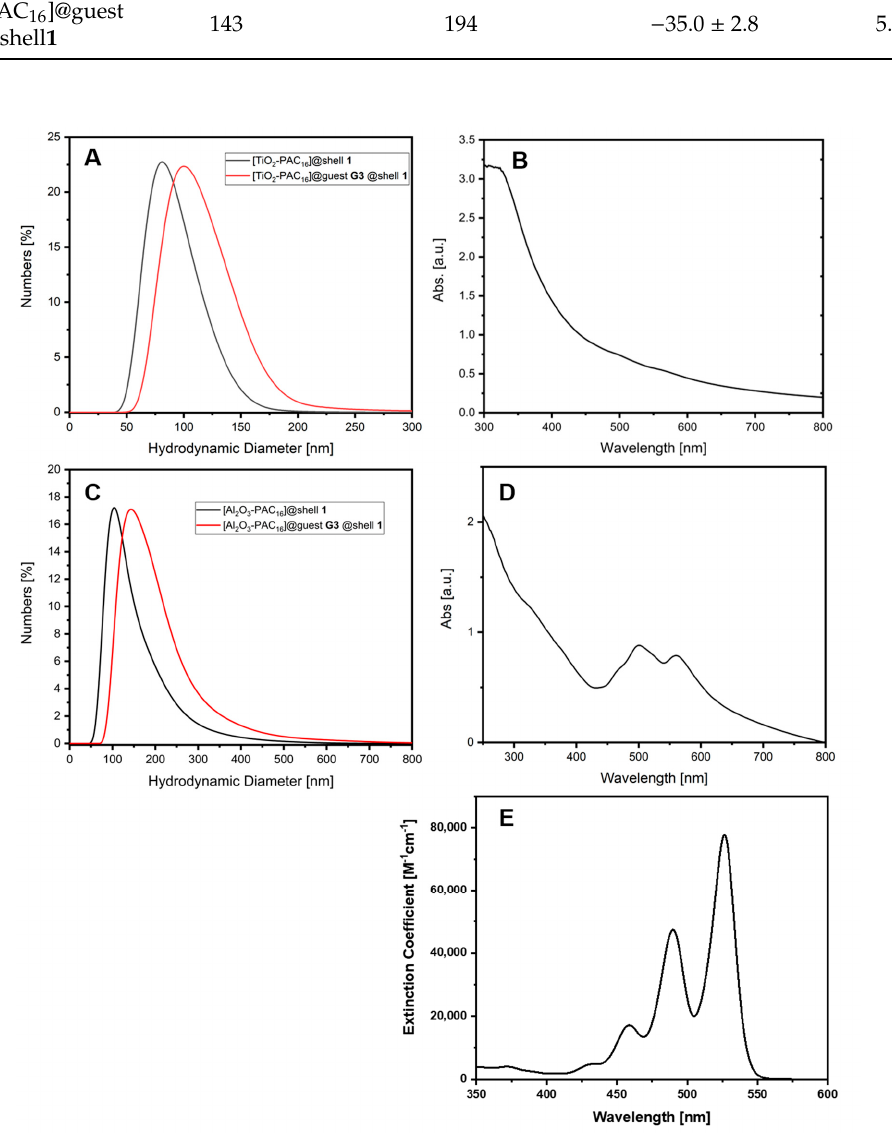
Figure 3. Comparison of the hydrodynamic diameters of the unloaded nanocarriers with that of the nanocarriers loaded with G3 (perylendiimide): ( A ) TiO 2 nanocarriers, ( C ) Al 2 O 3 nanocarriers; UV/Vis spectrum of the loaded nanocarriers [TiO 2 -PAC 16 ]@guest G3 @shell 1 ( B ) or [Al 2 O 3 -PAC 16 ]@guest G3 @shell 1 ( D ) and the perylendiimide ( G3 ) in toluene ( E